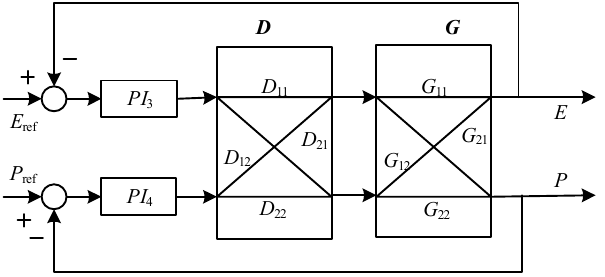
Figure 9. Block diagram of decoupling control scheme of the PB subsystem.